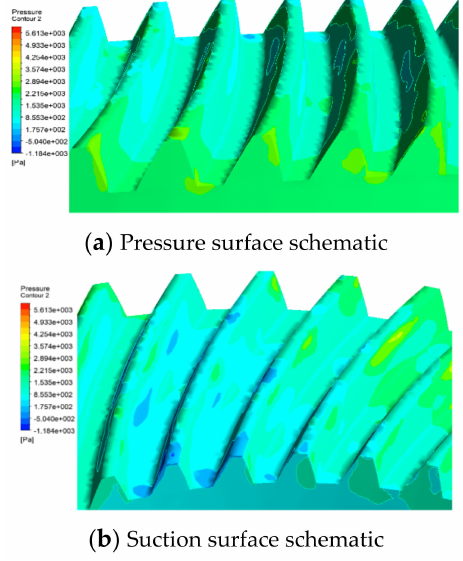
Figure 5. Pressure distribution of fluid on teeth.